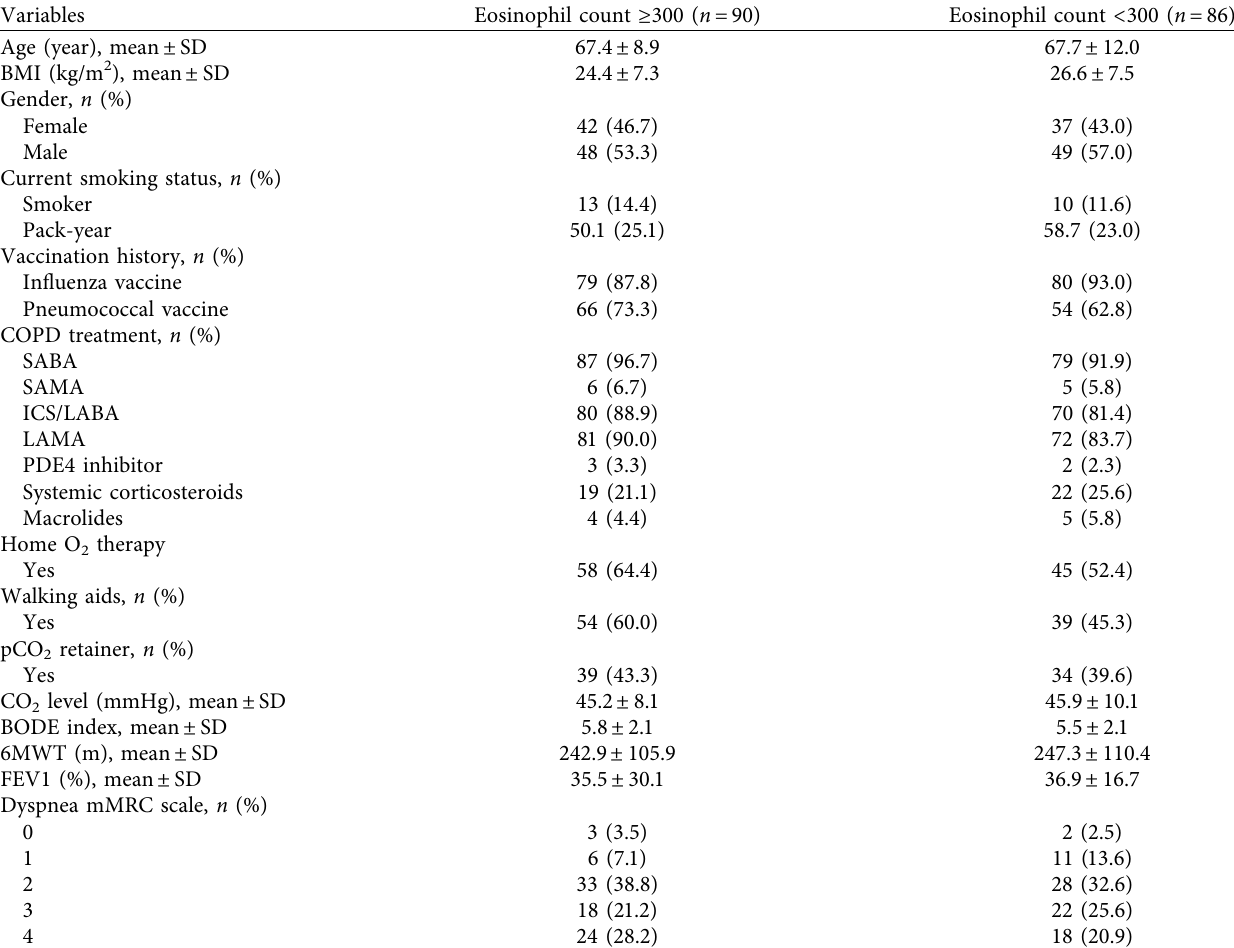
Table 1: Baseline characteristics of the study participants.